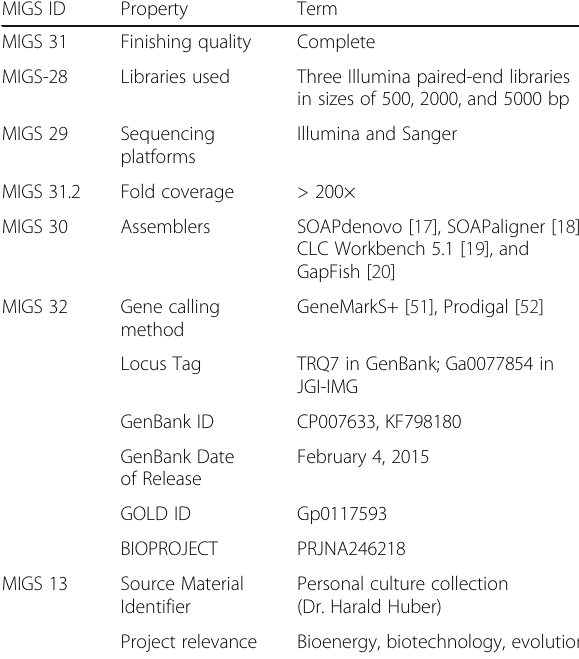
Table 2 Project